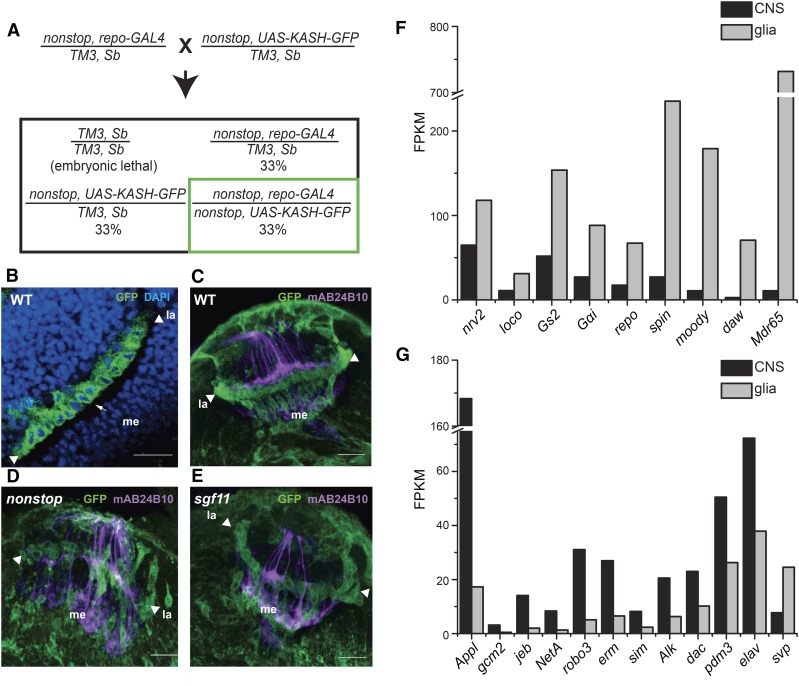
Glial nuclei are labeled with KASH-GFP in wild-type, nonstop and sgf11 optic lobes. (A) Genetic scheme for positive labeling of glial nuclei in nonstop or sgf11 homozygous mutant larvae. The expected percentage of progeny with each genotype at the larval stage is indicated. (B) Glial nuclei in a wild-type optic lobe were positively labeled with KASH-EGFP (GFP, green) and stained with DAPI (blue). Arrowheads mark the edges of the lamina (la), and the medulla (me) is indicated. A single KASH-GFP labeled glial nuclei is indicated by the arrow. Scale bars, 20 μm. (C–E) Glial nuclei in wild-type (C), nonstop (D), and sgf11 (E) optic lobes were positively labeled with KASH-EGFP (GFP, green). Mutant genotypes (panels D and E) were labeled using the genetic approach described in panel A. In third instar larvae, R1–R8 photoreceptor axons (anti-chaoptin, mAB24B10, magenta) extend axons from the eye imaginal disc into the optic lobe where these terminate in either the lamina (R1–R6, la) or medulla (R7–R8, me). In the wild-type optic lobe, R1–R6 photoreceptor axons form a densely packed growth cone, whereas in nonstop and sgf11 optic lobes, a subset of photoreceptor axons project through the lamina into the medulla. Arrowheads mark the edge of lamina. Scale bars, 20 μm. (F) Bar graph indicating the transcript level (FPKM) for glial markers in affinity-enriched glia (glia: this study) relative to the larval central nervous system (CNS: ModEncode). (G) Bar graph indicating the transcript level (FPKM) for neuronal markers in affinity-enriched glia relative to the larval central nervous system. CNS, central nervous system; DAPI, 4′,6-diamidino-2-phenylindole; EGFP, enhanced green fluorescent protein; FPKM, fragments per kilobase of transcript per million mapped reads; GFP, green fluorescent protein; KASH, Klarsicht, Anc-1, and Syn3-1 homology; WT, wild-type.